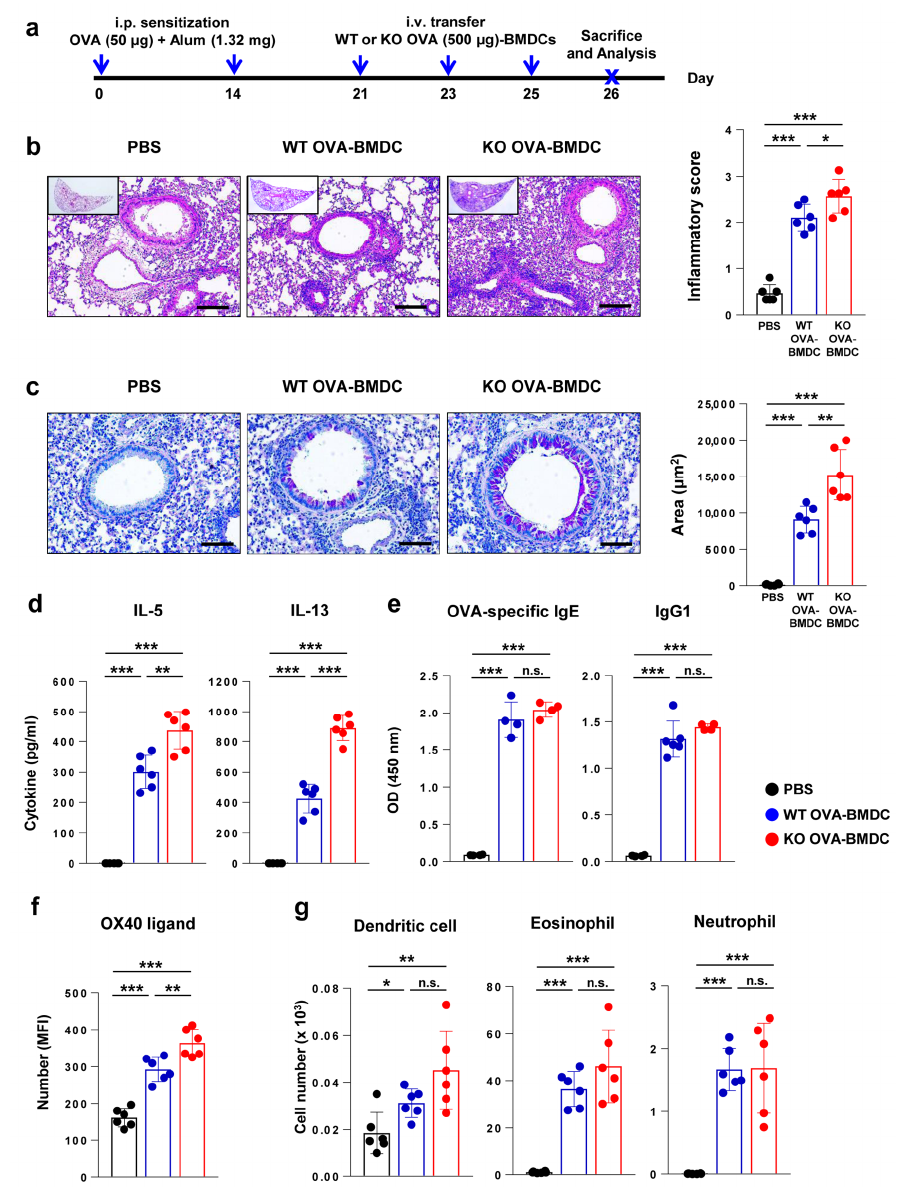
Figure 6 Figure 6. Comparison of allergic asthma phenotype and relevant immune responses following the adoptive transfer of bone marrow-derived dendritic cells (BMDCs) from wild-type (WT) and Flt3 knockout (KO) mice. ( a ) Experimental schematic protocol of allergic asthma induction through the intravenous transfer of ovalbumin (OVA)-loaded BMDCs. Arrows indicate the time points of procedures or sacrifice. i.p., intraperitoneal; i.v., intravenous. ( b ) Representative hematoxylin and eosin-stained sections (original magnification: × 100, magnified image of the × 10 figure in the left upper quadrant) and inflammatory score based on lung histology (scale bar: 100 µ m). ( c ) Representative periodic acid-Schi ff (PAS)-stained section (original magnification: × 200) and PAS-positive areas based on lung histology (scale bar: 50 µ m) in mice administered BMDCs from WT and Flt3 KO mice. ( d ) Cytokines measured by ex vivo recall assays with OVA protein (10 µ g / mL) in isolated mediastinal lymph node cells. ( e ) OVA-specific IgE and IgG1 in serum, as measured using ELISA. ( f ) OX40 ligand level in lung DCs, as measured by flow cytometry. ( g ) Immune cell population of BALF. Data are representative of two independent experiments with six mice / group in each experiment. The results are expressed as the mean ± standard deviation. One-way analysis of variance followed by Tukey’s multiple comparison tests was used to evaluate the significance of di ff erences. * p < 0.05, ** p < 0.01, *** p <